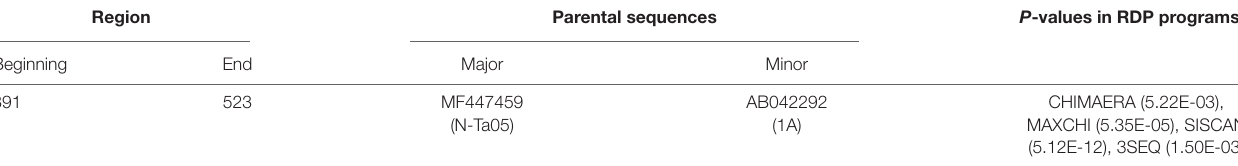
TABLE 5 | Recombination signals within the partial RNA1 sequences of CMV isolate ‘29T_Ibi’ (accession number MH798810) from Nigeria, as identified in RDP4. Region Parental sequences P -values in RDP programs